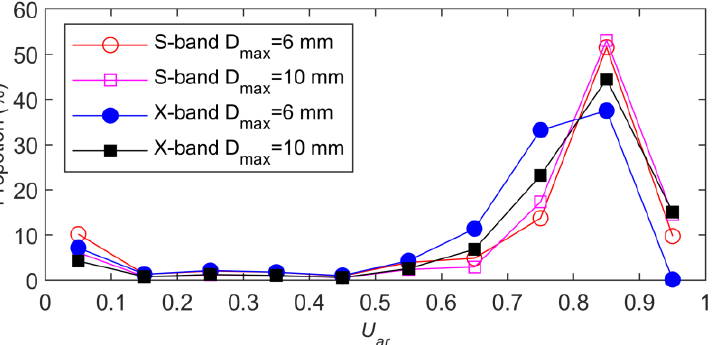
Figure 6. Distribution of U ar within the enumeration range of the RSD parameters. (The values of D 0 and μ are the same as those in Figure 5).